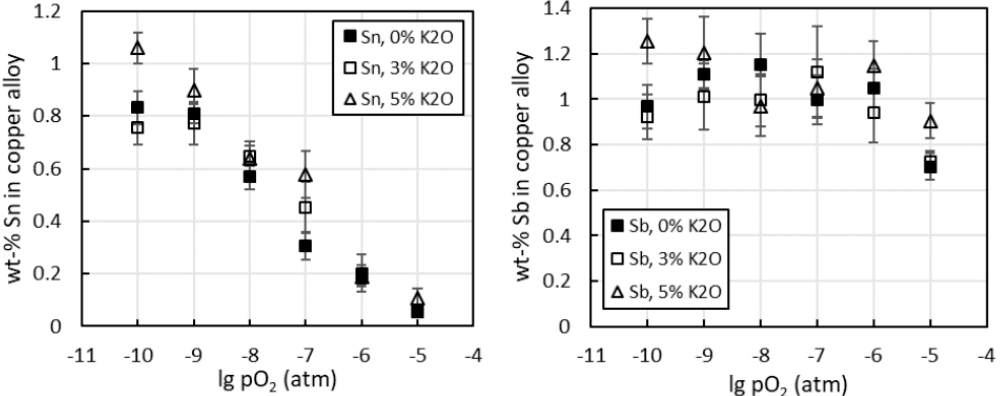
Figure 5. Left side: concentration of tin in copper alloy phase. Right side: concentration of antimony in copper alloy as a function of oxygen partial pressure.